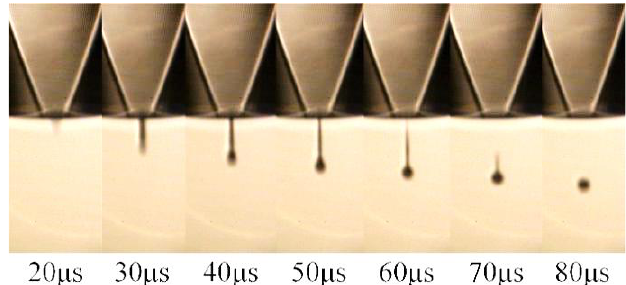
Figure 19. Experimental results when the t f is 2 µs.